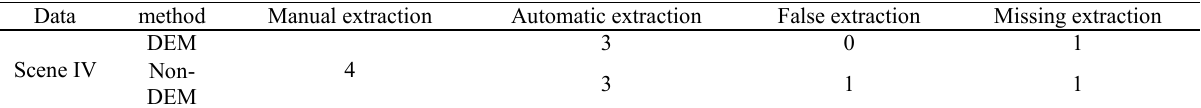
Table 1 Statistical results of the influence of DEM data on identification